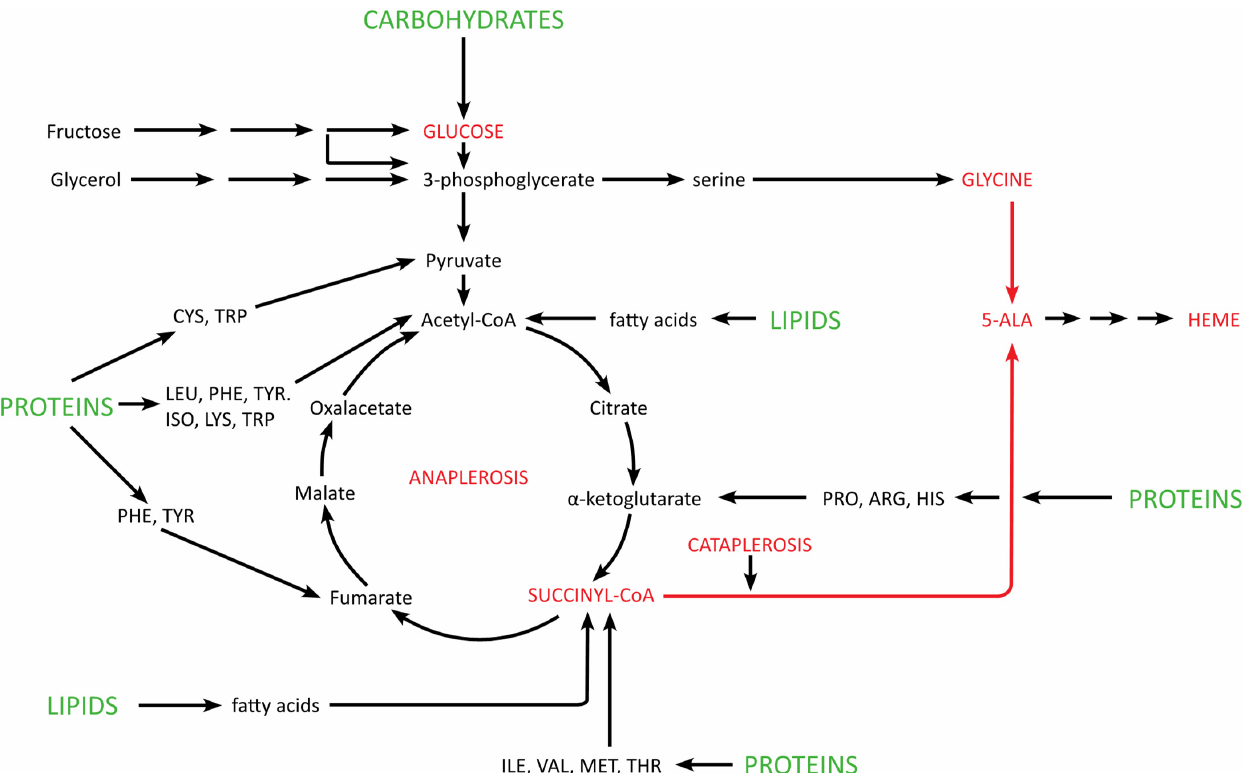
Figure 3. Integration of heme biosynthesis into carbohydrate, lipid and protein metabolism. Heme synthesis uses succinyl-CoA (cataplerosis), which is replenished by the TCA cycle (anaplerosis). 1.3. Regulation of Heme Biosynthesis and Degradation